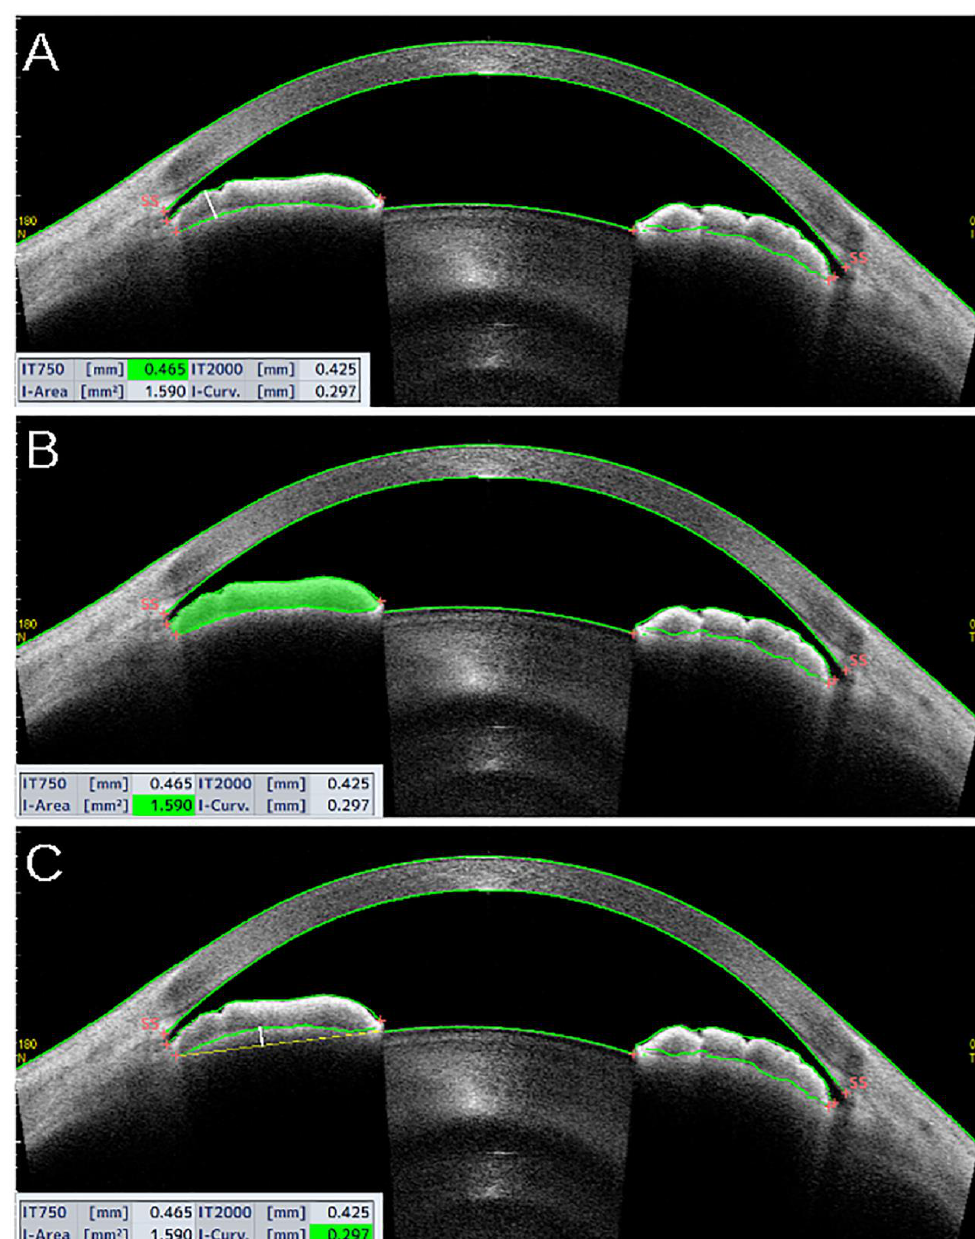
Figure 4. Tomey Casia 2 AS-OCT scans (Nagoya, Japan) showing iris thickness ( A ), area ( B ), and curvature ( C ) from a patient with narrow angles. ( A ) The iris thickness (IT) is the thickness of the iris at different distances from the SS. In the example, IT measured at 750 microns (IT750) from the scleral spur (white, bold vertical line). ( B ) The iris area is defined as the entire cross-sectional area of the iris, from the SS to the pupil. ( C ) The iris curvature is the perpendicular distance from the iris-pigmented epithelium at the point of greatest convexity to a line between the most peripheral and the most central points of the iris-pigmented epithelium (white, bold vertical line).